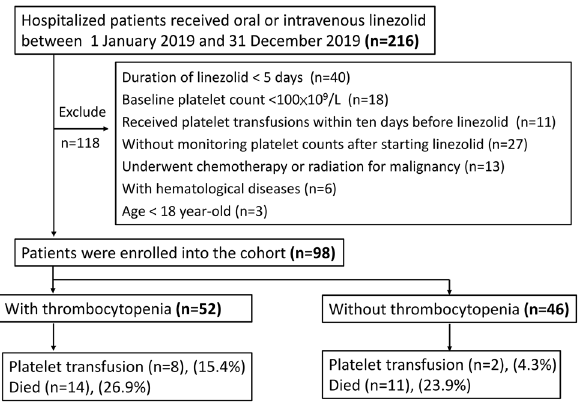
Figure 1. Flow chart showing enrollment into the study and clinical